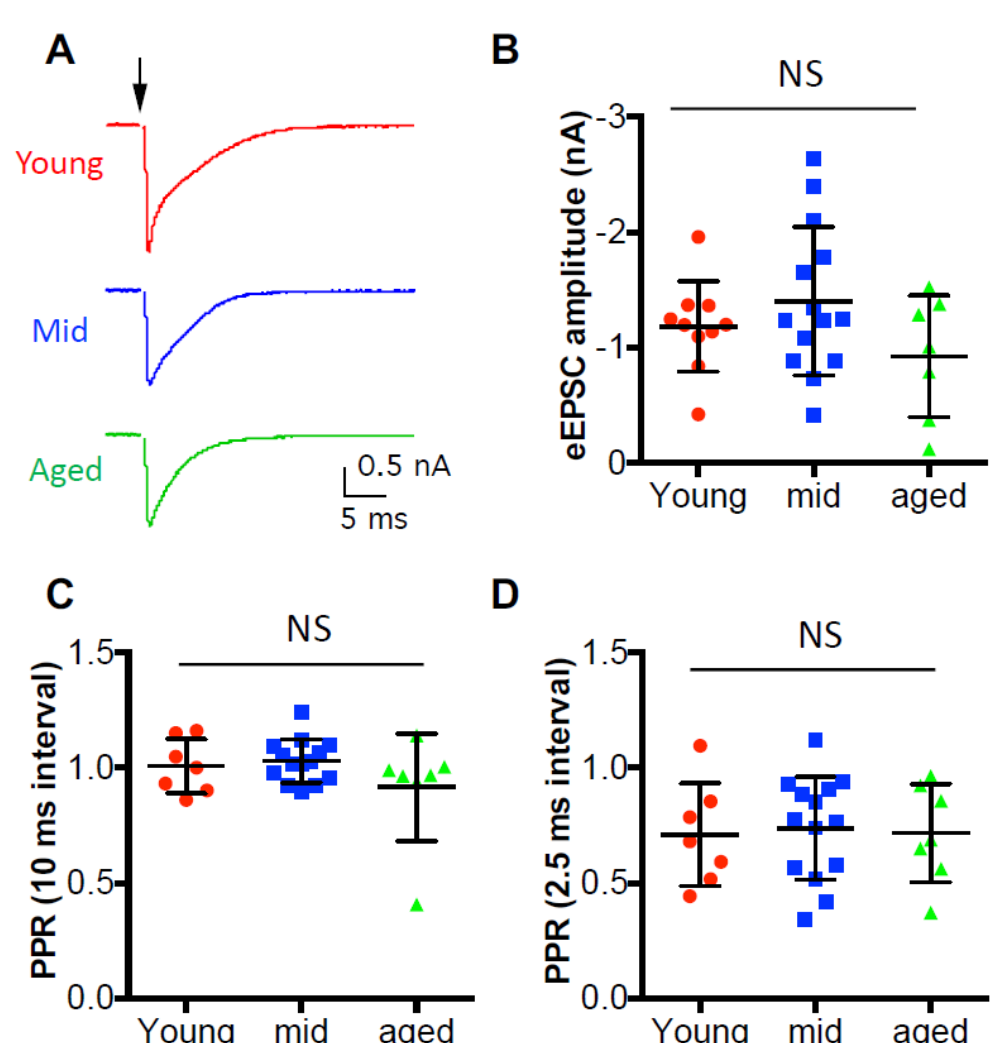
Figure 5. Synaptic inputs to D-stellate neurons under quiescence show no change during aging. ( A ) Single stimulation at the auditory nerve evoked excitatory postsynaptic current (EPSCs) in three example D-stellate neurons from three age groups. Arrow: stimulus onset. ( B ) Summary plot of the EPSC amplitude in all three groups. ( C ) Paired pulse ratio (PPR) of EPSC amplitudes at 10 ms interval. ( D ): Paired pulse ratio of EPSC amplitude at 2.5 ms interval. NS: not significant (Kruskal–Wallis test: p > 0.05).